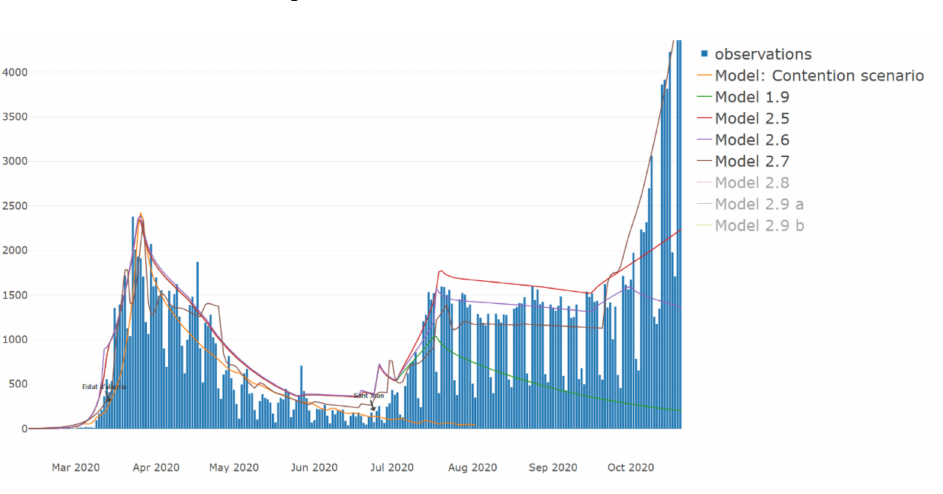
Figure 6. Forecast for the new infections ( y -axis), the red line for the 2.5 SDL model (being this an optimistic scenario). We consider other scenarios in case 2.5 model hypotheses fail, model 2.6, and model